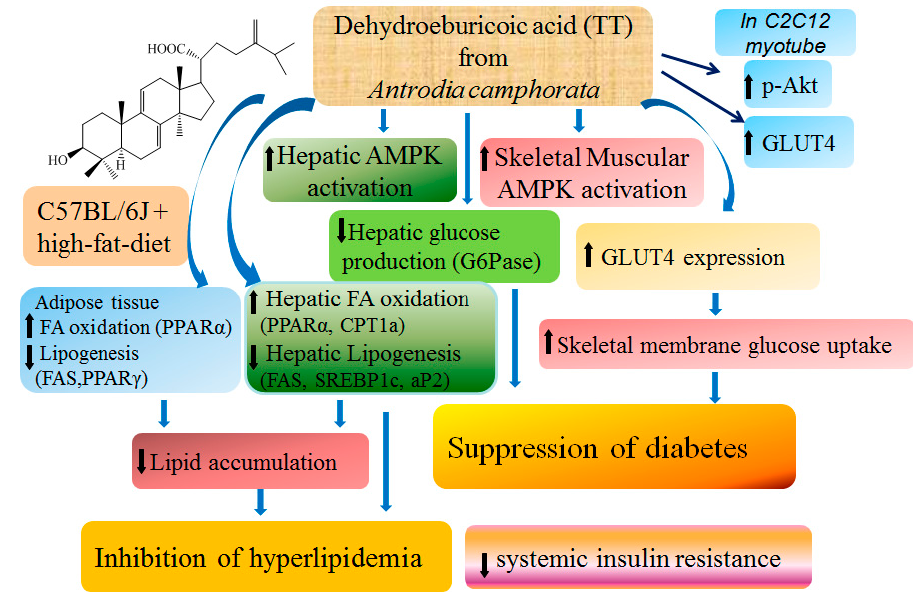
Figure 7. The graphic abstract of dehydroeburicoic acid (TT). ↑ : increase; ↓ : decrease.